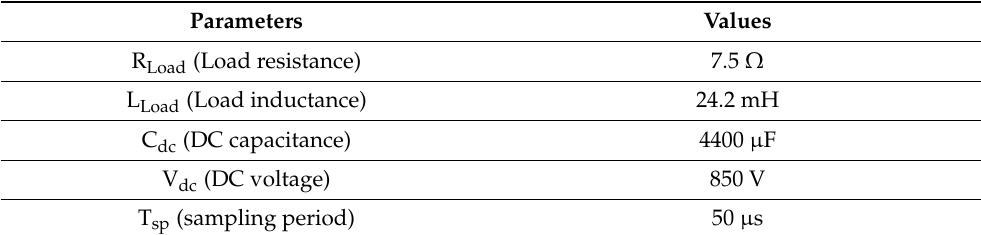
Table 5. Parameter for inverter